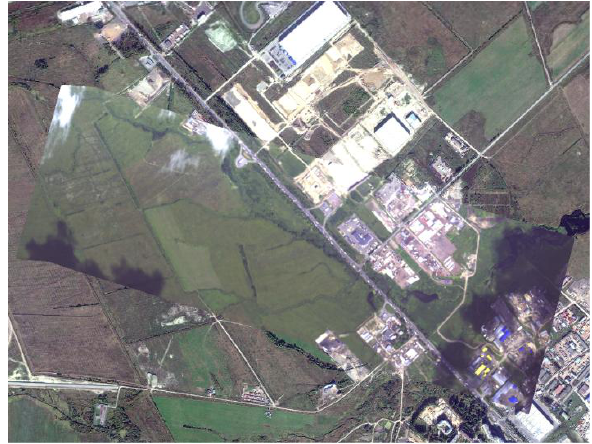
Image 6. A test image from the second series corrected with described